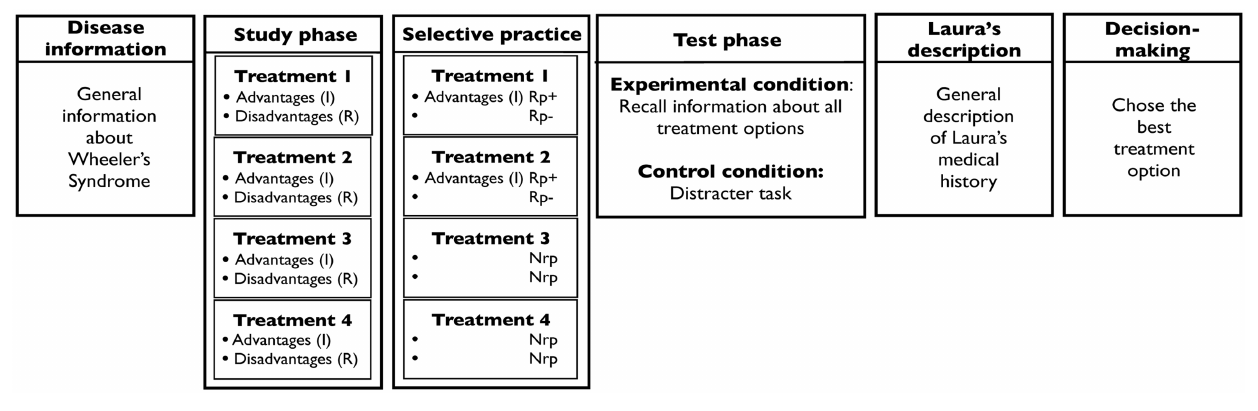
FIGURE 3 | Phases of Experiment 2, for the PositiveValence condition . In the Study and Selective practice phases, R stands for relevant information; I stands for irrelevant information; Rp + for retrieval practice plus; Rp − for retrieval practice minus, and Nrp for no retrieval practice. In the Negative